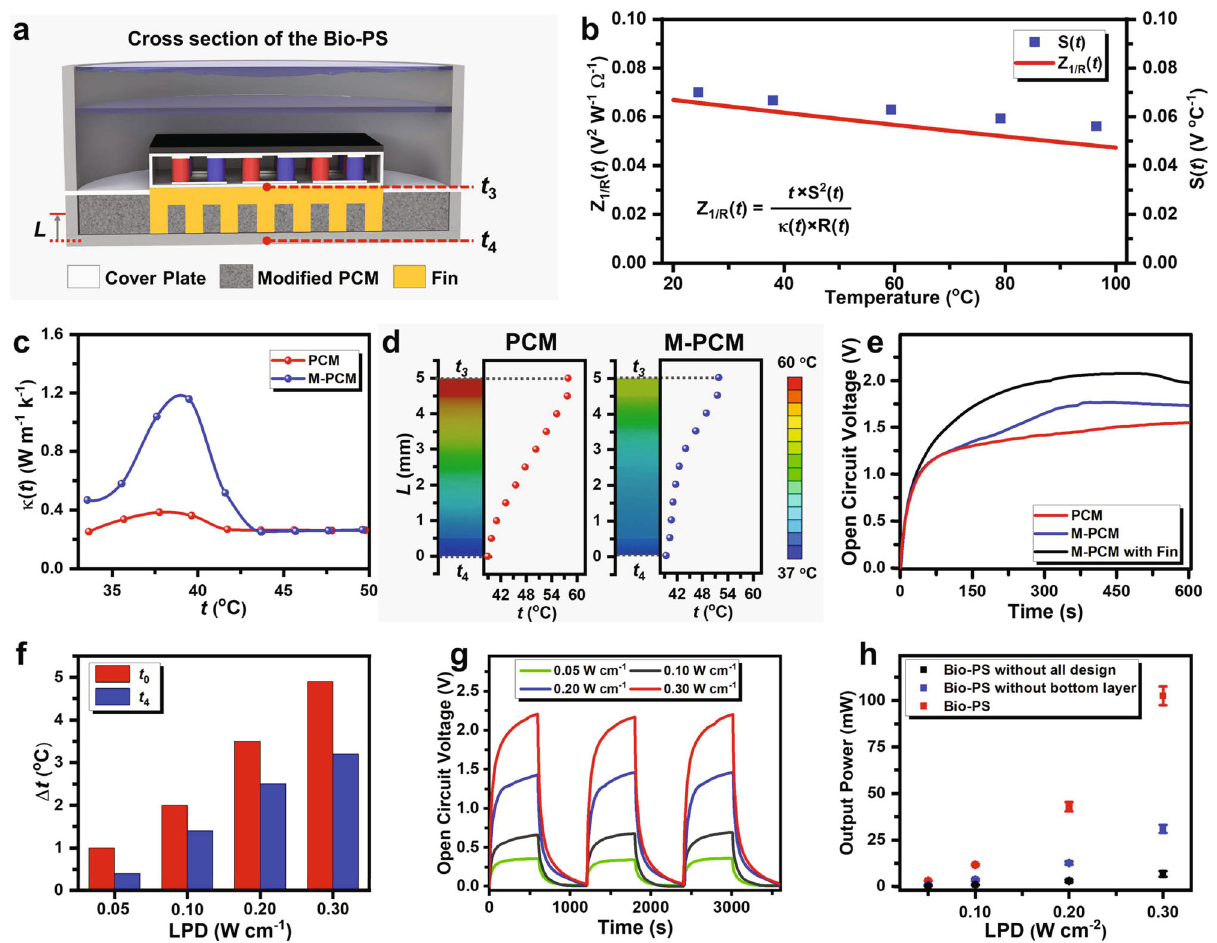
Fig. 4 | The design of the bottom layer, and the characterization as well as safety test of Bio-PS. a Schematic illustration of the cross-section of the bottom layer. b Thermoelectric fi gure of merit ( Z 1/R ( t ), thermoelectric fi gure of merit de fi ned by resistance instead of electrical conductivity and Seebeck coef fi cient ( S ( t ))of TEgenerator atdifferent qualitative temperatures. c Thermalconductivity of the phase change material (PCM) and black carbon-modi fi ed PCM (M-PCM) at varied temperatures. d The temperature distribution through the center of the bottom layer under constant heat fl ow for 10min predicted by Ansys, and the statisticalcurveoftemperaturewithdifferentlengthsofPCMs( L) Theheat fl uxwas 2.0W. e Time-dependent open circuit voltage output by TE generator with the